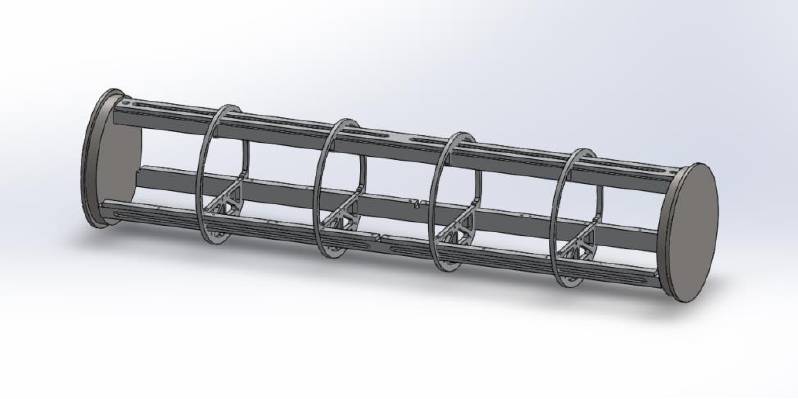
Figure 12. Detail of the sliding stiffeners inserted into the AUV.